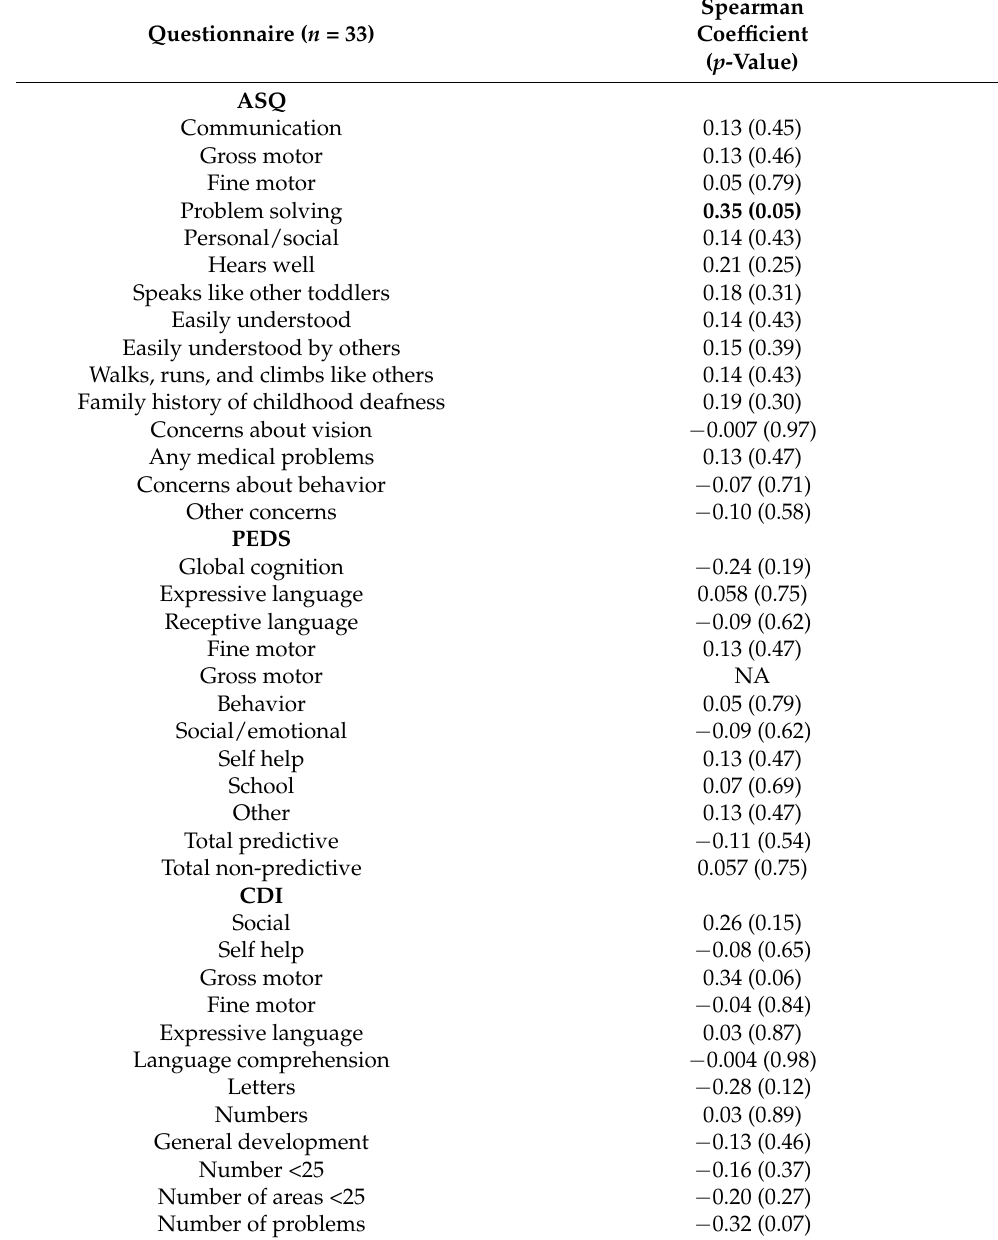
Questionnaire ( n = 33)